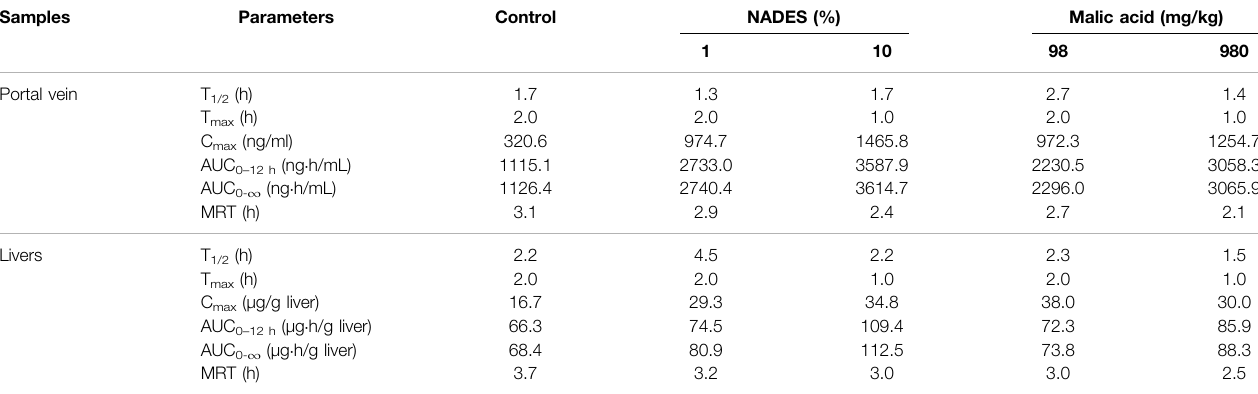
TABLE 4 | Pharmacokinetic parameters of berberine in the portal veins and livers of the mice that were orally administered with berberine hydrochloride (BBR, 200 mg/kg) (Mean ± SD, n (cid:2) 6). Samples